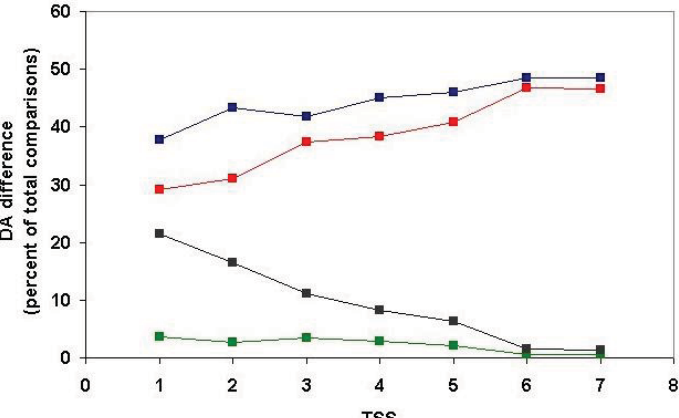
Figure 8. Analysis of the positional distribution of DA differences in clusters defined by strong component analysis of sequence similarity networks of human Swiss-Prot sequences. The numbers on the abscissa indicate the number of top-scoring matches included in the analyses (TSS = 1, .... TSS = 7) used to define paralogous clusters. N-terminal differences (blue rectangles), C-terminal differences (red rectangles), internal differences (green rectangles), tandem duplications (black